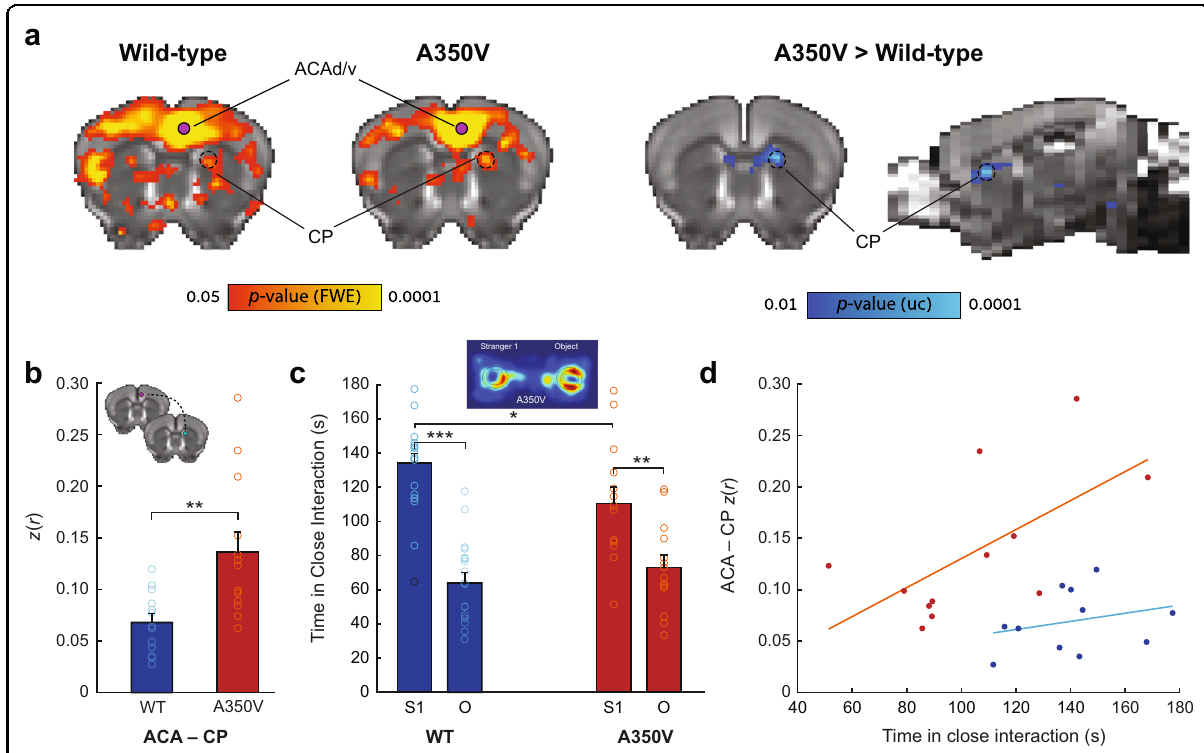
Fig. 5 Corticostriatal functional connectivity correlates with disrupted sociability in A350V mice. a Seed-based comparison of the ACAv/d showing fcMRI statistical parametric maps ( red-yellow ) of positive correlations for WT ( left ) and A350V mice ( right ) ( p < 0.05, corrected for multiple comparisons using whole-brain family-wise error (FWE) rate correction) and an fcMRI statistical parametric map ( blue-light blue ) of increased connectivity in A350V relative to WT showing signi fi cant increase in the dorsomedial CP (two-sample unpaired t test, p = 0.04, FWE cluster-corrected, with cluster-de fi ning threshold of t (24) > 2.49, p < 0.01, voxel extent ≥ 5 and Bonferroni network-level corrected, with network-de fi ning threshold of p < 0.0125). All maps are displayed on a downsampled version of the AMBC Atlas that matches the original fMRI resolution. Purple circles indicate the ACAd/v seed location. Black dashed circle indicates CP cluster that was found signi fi cant. b Seed-to-seed correlation between ACAd/v and CP showing increased connectivity in A350V mice. Colored circles indicate individual subject z(r) values. Coronal slices showing seed location for ACAd/v ( purple ) and CP ( green ) ( top left ). c Duration of time spent in close interaction with Stranger 1 (S1) and an object (O) in the three-chamber social preference test demonstrating that both A350V and WT prefer interacting with S1, although this preference is less pronounced in A350V. Colored circles indicate individual subject variability in sociability measurement with black circles indicating outlier in the data. A representative heat map analysis of A350V mouse is depicted ( top center ). d Connectivity between ACAd/v and CP in relation to sociability showing signi fi cant correlation for A350V mice only. Data indicate mean ± SEM. Mann – Whitney U -test ( a ); ** p < 0.01. Two-way rmANOVA, with Holm – Bonferroni post hoc t test ( c